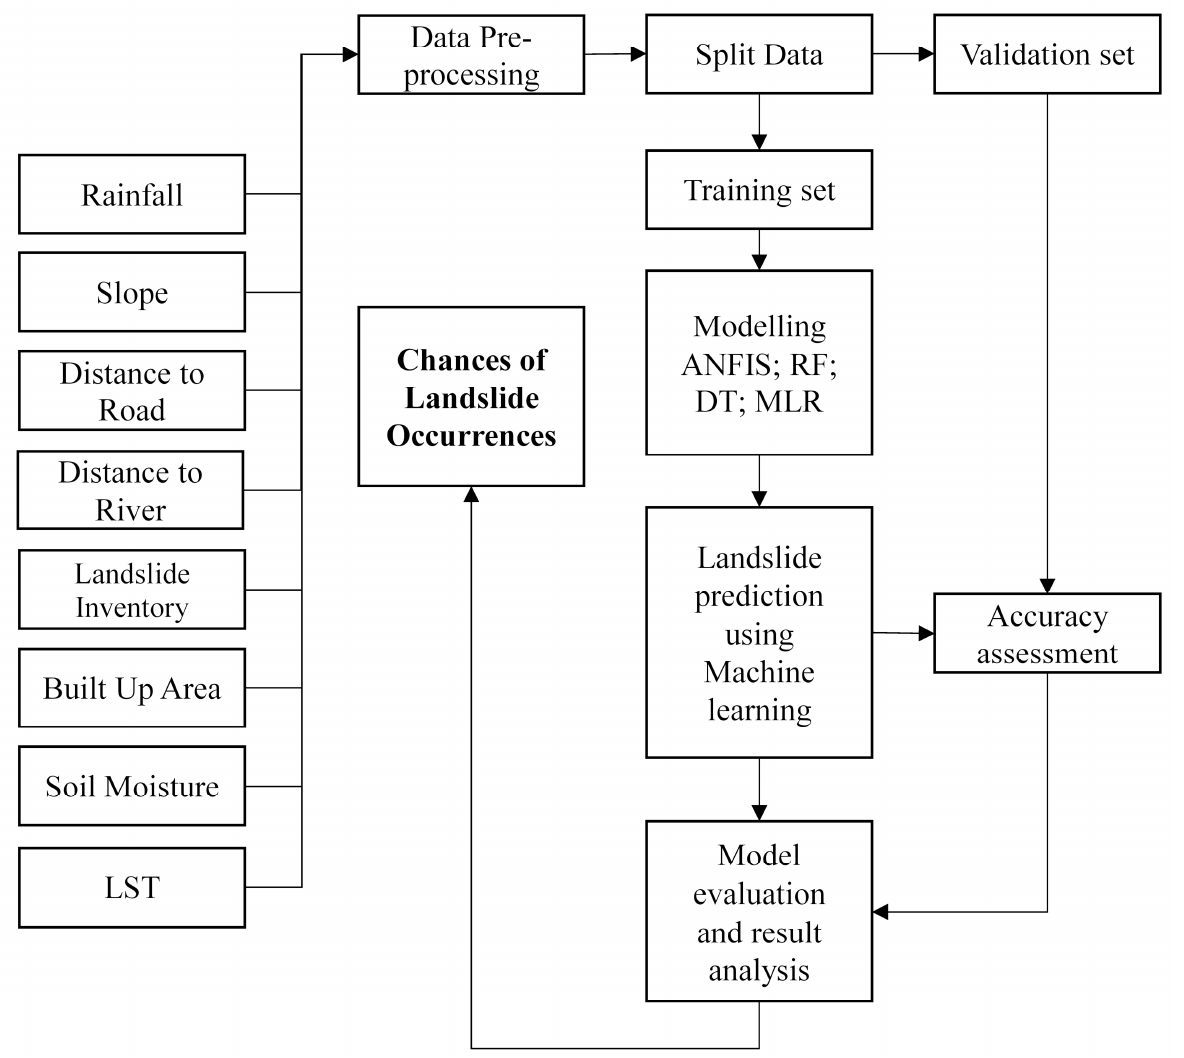
Figure 5. Flow chart of the overall LEWS framework used in the present study.